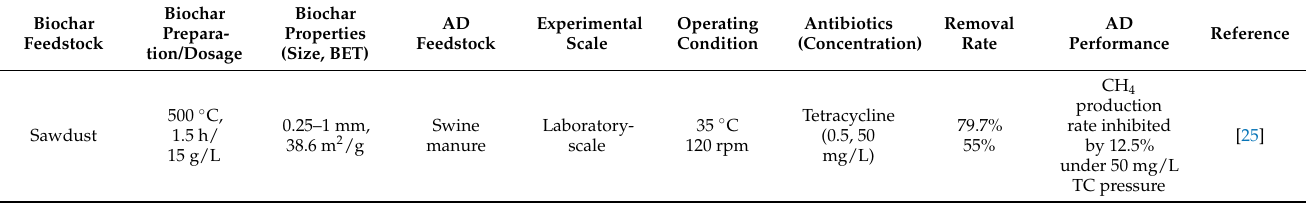
Table 1. Application of biochar-facilitated DIET for alleviating antibiotics inhibition and enhancing